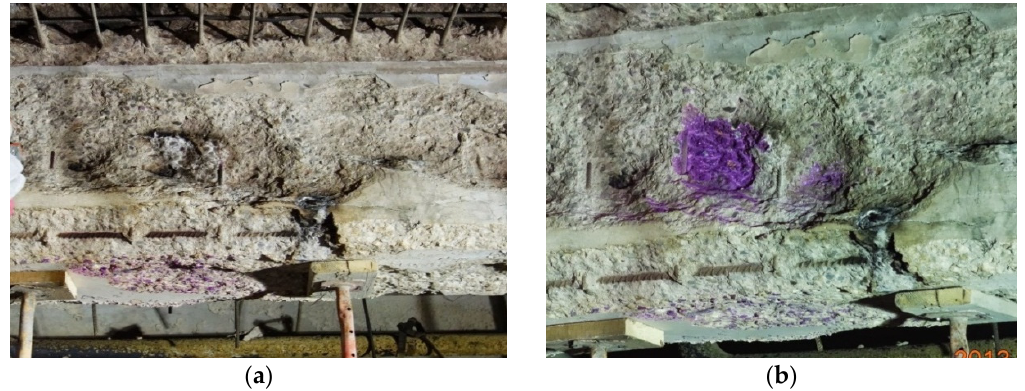
Figure 9. Neutralization tests on damaged concrete. ( a ) Tests on a sample piece of slab concrete. ( b ) Test on the surface of wall.